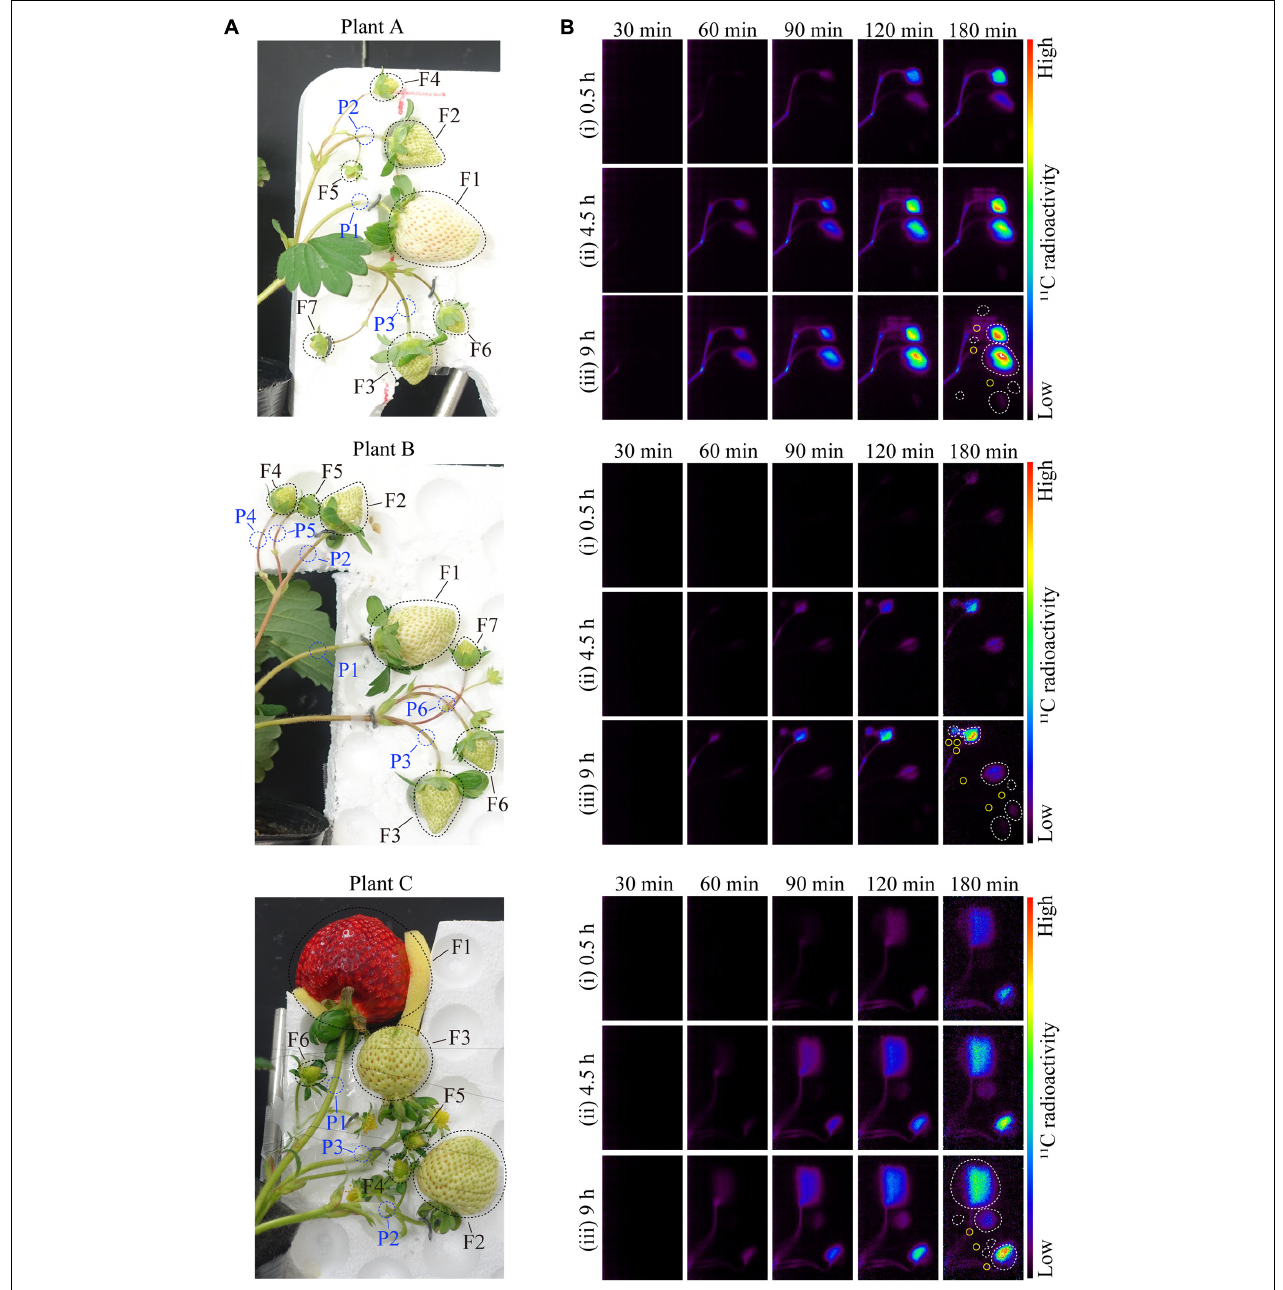
FIGURE 2 | (A) Image of strawberry fruits from Plants A–C in the PETIS field of view. The black- and blue-dotted ellipses indicate the regions of interest (ROIs) on the fruits and pedicels, respectively. The F and P numbers in the figure indicate the fruit and pedicel numbers, respectively. The positions of the fruits on the same inflorescence are as follows: Fruit 1, primary; Fruits 2 and 3, secondary; and Fruits 4–7, tertiary. (B) Several PETIS images of 11 C-photosynthate translocation into the fruits of Plant A for the (i) 0.5-h, (ii) 4.5-h, and (iii) 9-h lighting treatments. Each image represents the 5-min average for the time period indicated at the top of each PETIS image, which indicates the time elapsed since the start of PETIS imaging. The white and yellow ellipses indicate the ROIs of the fruits and pedicels,